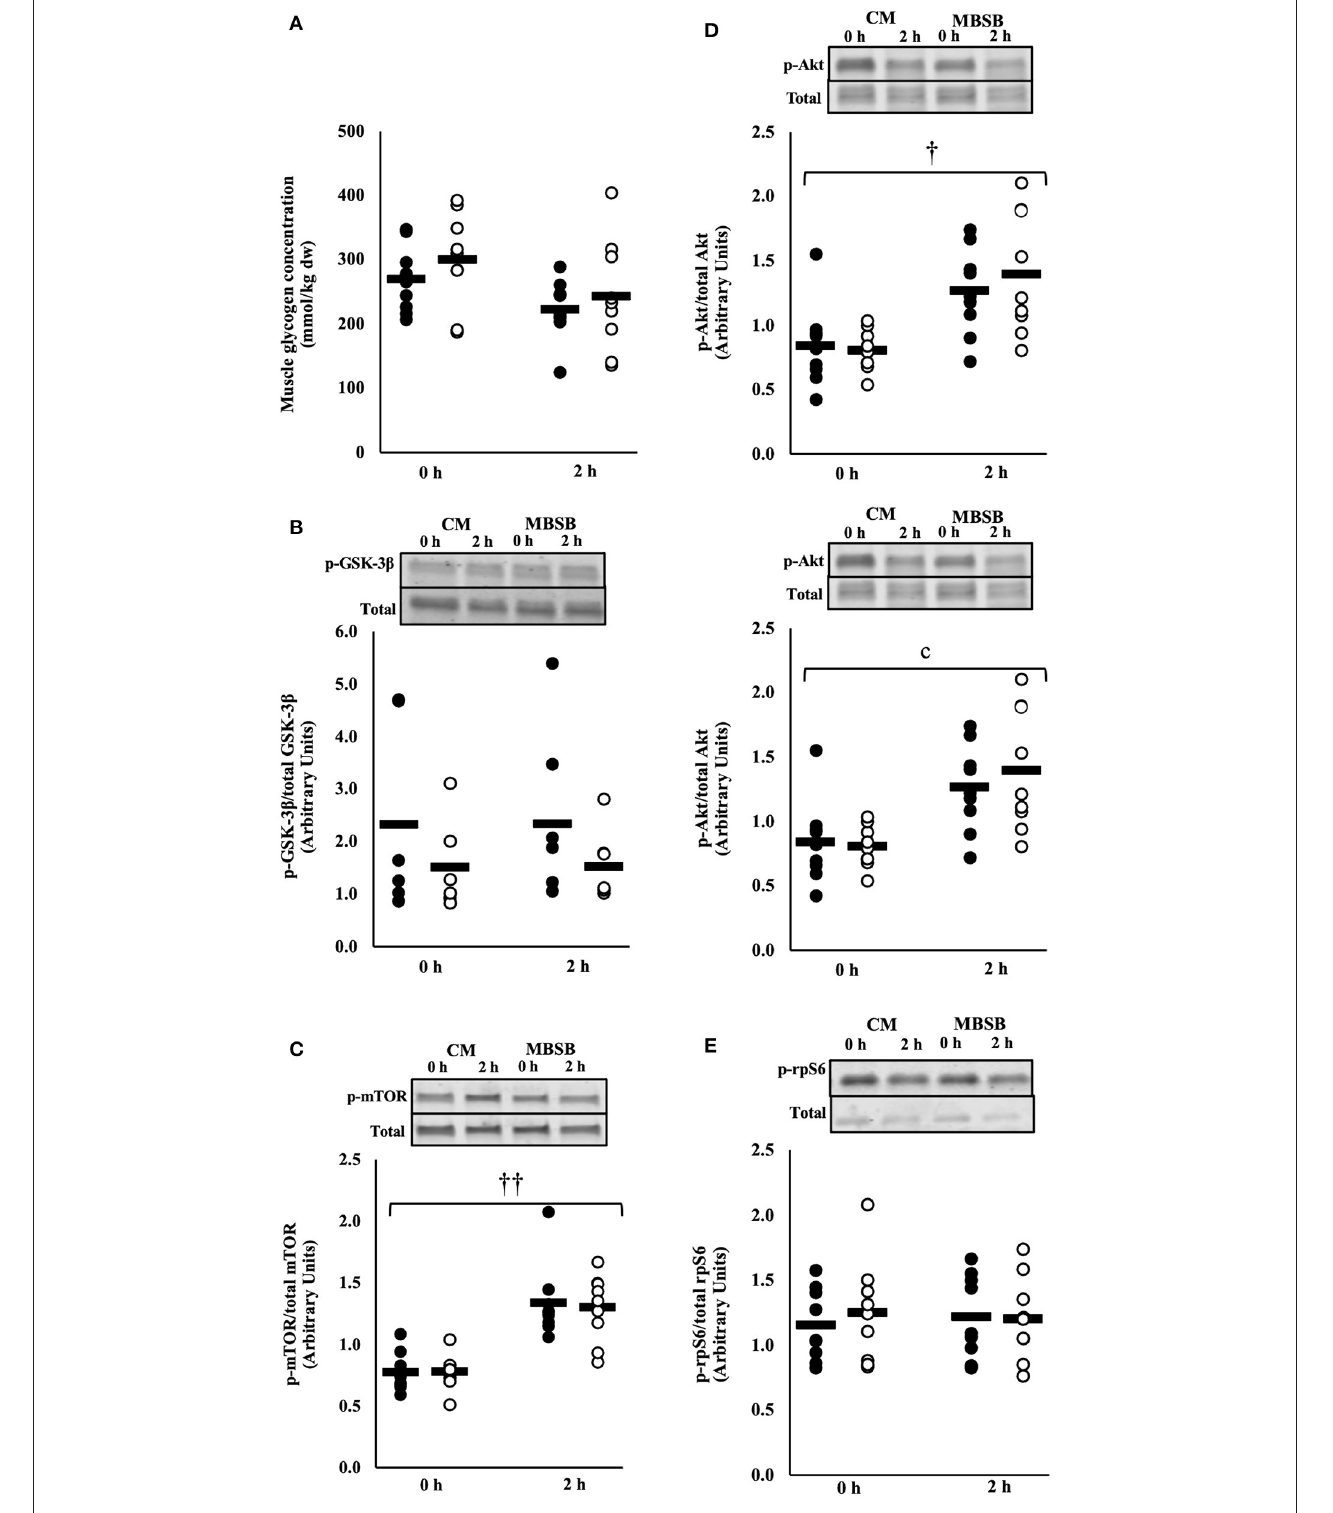
FIGURE 5 | Muscle glycogen content (A) , phosphorylated GSK3- β to total GSK3- β (B) , ratio of phosphorylated mTOR to total mTOR (C) , phosphorylated Akt to total Akt (D) , and phosphorylated rpS6 to total rpS6 (E) after 2h HIIT exercise in temperate ambient conditions and consumption of a whole food dairy milk (CM: (cid:4) ) and a reconstituted milk based supplement (MBSB: (cid:3) ) recovery beverage. Mean and individual responses ( n = 9): MEOTime †† P < 0.01 vs. 0h recovery, † P < 0.05 vs. 0h recovery.